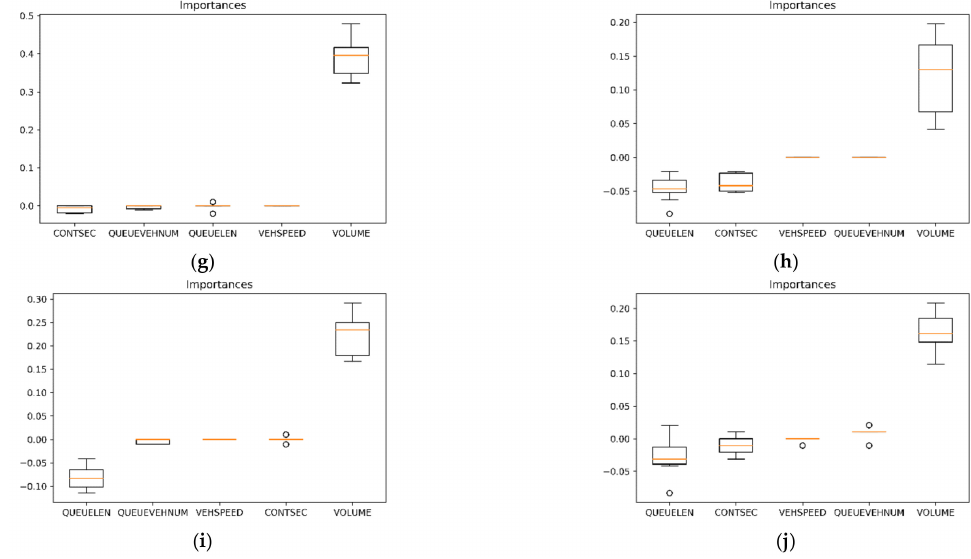
Figure 4. Comparison of traffic flow variable selection between working day and rest day: ( a ) shows characteristics of traffic flow data distribution about Lane 2 on workday, ( b ) shows characteristics of traffic flow data distribution about Lane 2 on holiday, ( c ) shows characteristics of traffic flow data distribution about Lane 3 on workday, ( d ) shows characteristics of traffic flow data distribution about Lane 3 on holiday, ( e ) shows characteristics of traffic flow data distribution about Lane 4 on workday, ( f ) shows characteristics of traffic flow data distribution about Lane 4 on holiday, ( g ) shows characteristics of traffic flow data distribution about Lane 5 on workday, ( h ) shows characteristics of traffic flow data distribution about Lane 5 on holiday, ( i ) shows characteristics of traffic flow data distribution about Lane 6 on workday, ( j ) shows characteristics of traffic flow data distribution about Lane 6 on